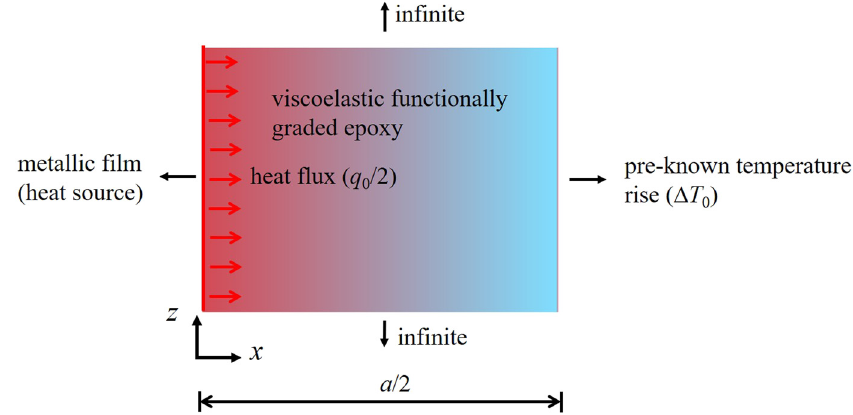
Figure 2: Simpli fi ed model of one - dimensional thermal